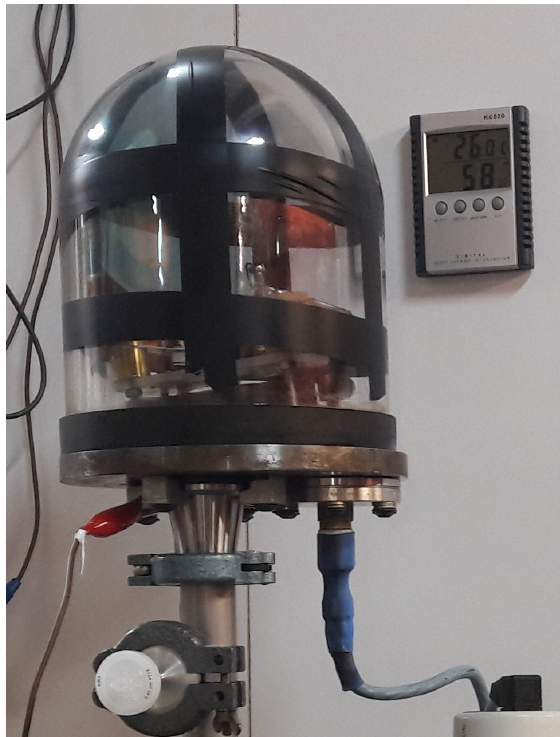
Figure 3. Chamber for measurements. The Pyrex glass jar, septum, and electrical contacts described in Section 2.3 are